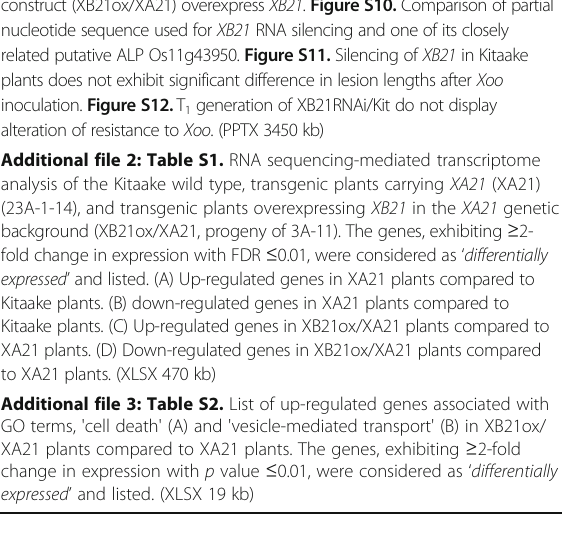
Additional file 2: Table S1. RNA sequencing-mediated transcriptome analysis of the Kitaake wild type, transgenic plants carrying XA21 (XA21) (23A-1-14), and transgenic plants overexpressing XB21 in the XA21 genetic background (XB21ox/XA21, progeny of 3A-11). The genes, exhibiting ≥ 2- fold change in expression with FDR ≤ 0.01, were considered as ‘ differentially expressed ’ and listed. (A) Up-regulated genes in XA21 plants compared to